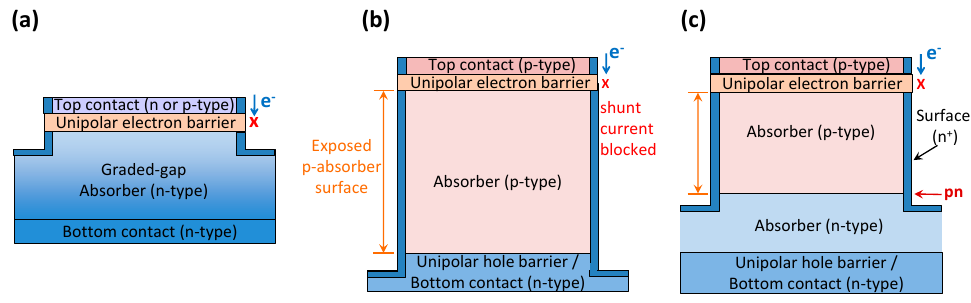
Figure 4 . Schematic generic device layer diagrams for ( a ) an n-CBIRD, ( b ) a p-CBIRD, and ( c ) a pn-CBIRD.